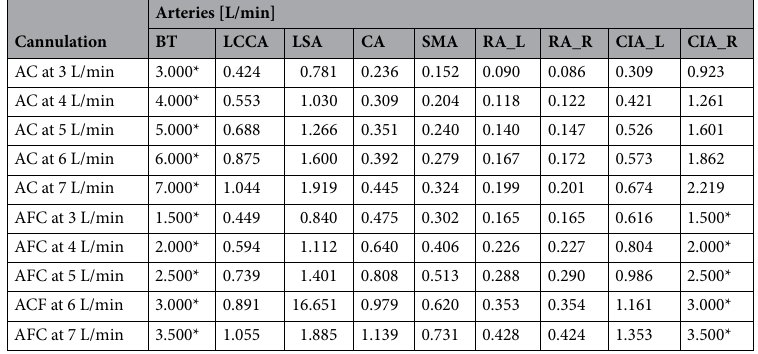
Arteries [L/min] Cannulation BT LCCA LSA CA SMA CIA_L